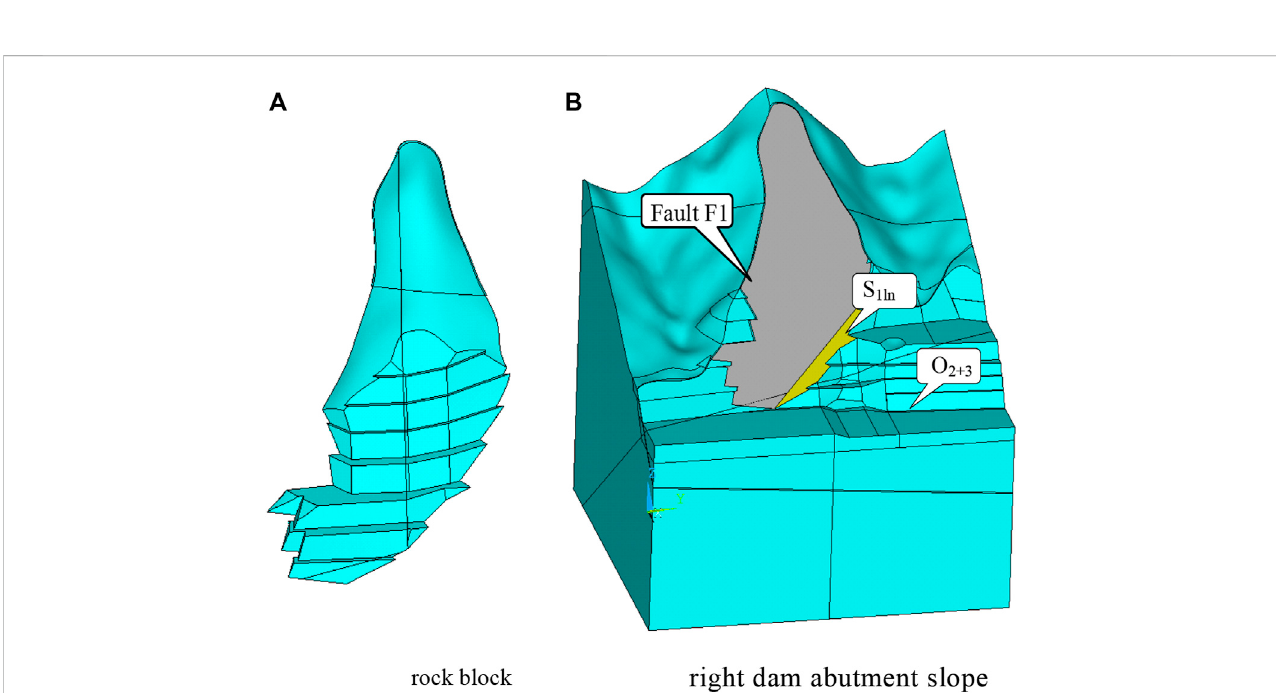
FIGURE 11 Three-dimensional model for the right dam abutment slope after excavation. (A) Rock block (B) Right dam abutment